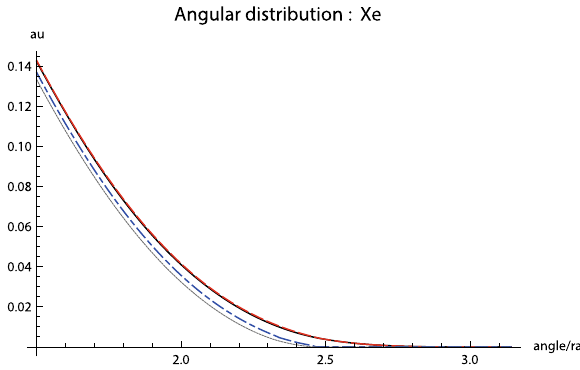
Fig. 8 RANP angular distribution with r = − 0 . 36532 of trivalent Ho from different inelastic Raman paths of | q (cid:2) = 5 I 7 , 655 . 0meV, 647.6meV, 638.2meV, and 637.7meV in the case of NO Majorana of smallest neutrino mass 30 meV